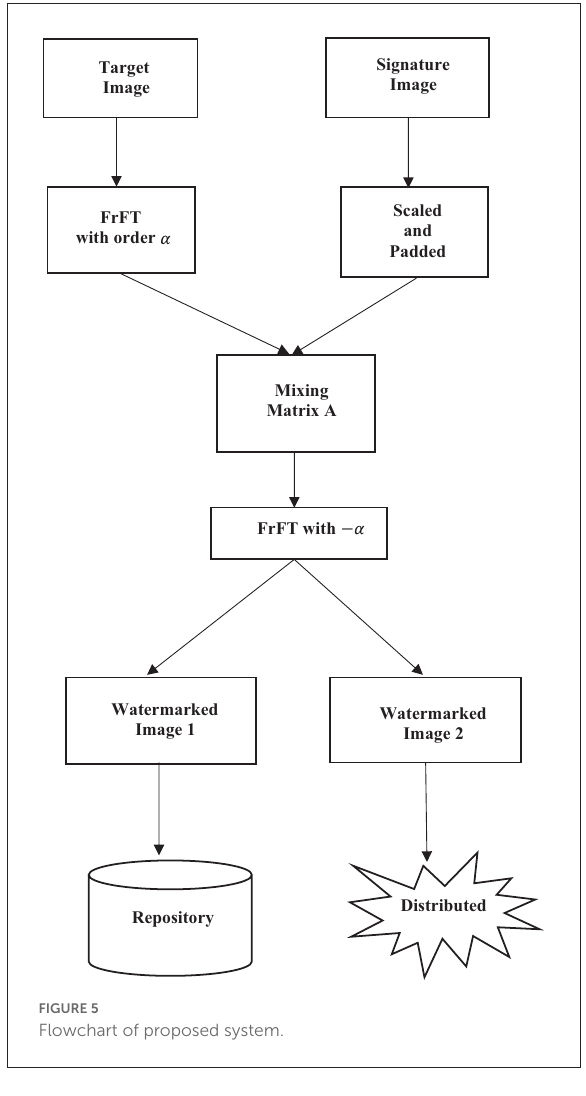
FIGURE5 Flowchart of proposed system.